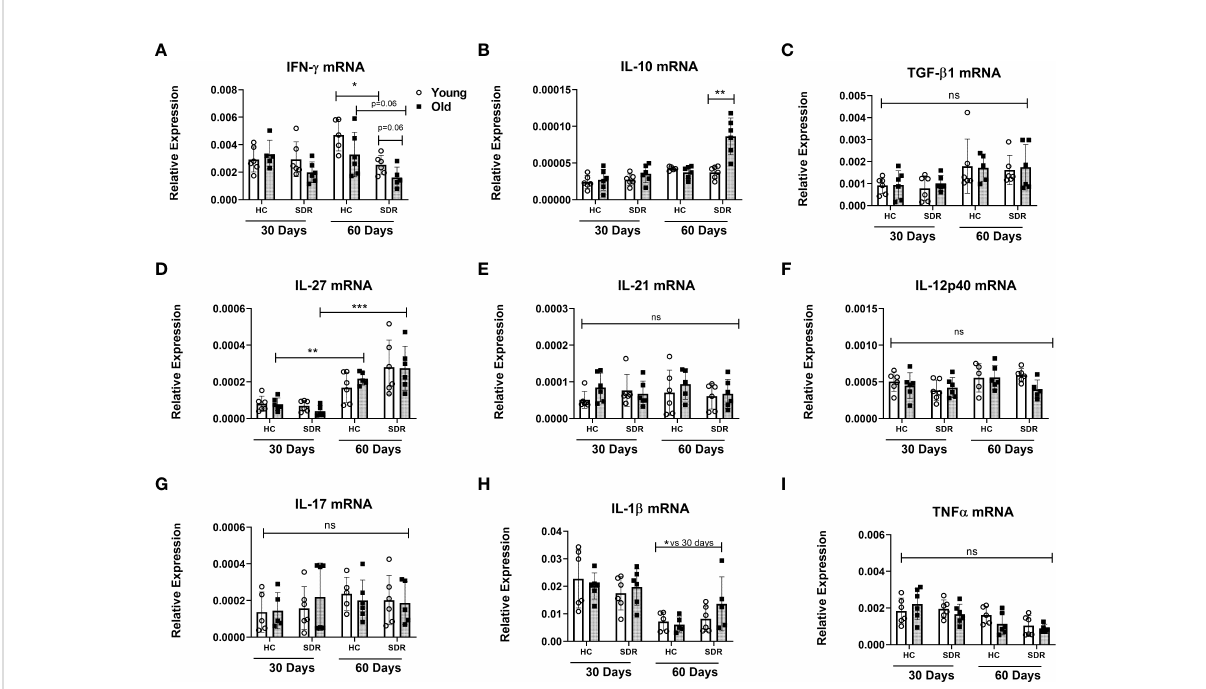
FIGURE 5 mRNA levels of cytokines genes in the lungs of mice infected with M.tb. Young and old Home Cage mice and mice subjected to six cycles of SDR were infected with low dose aerosol of M. tuberculosis for 30 and 60 days. RNA was isolated from a right lung lobe and mRNA levels determined by qRT-PCR (A-I) . RNA levels are expressed relative to b -actin. Results are pooled from two independent experiments. Each symbol represents individual mice. Data are shown as mean ± SE. Statistical analysis was performed by one-way ANOVA with Tukey